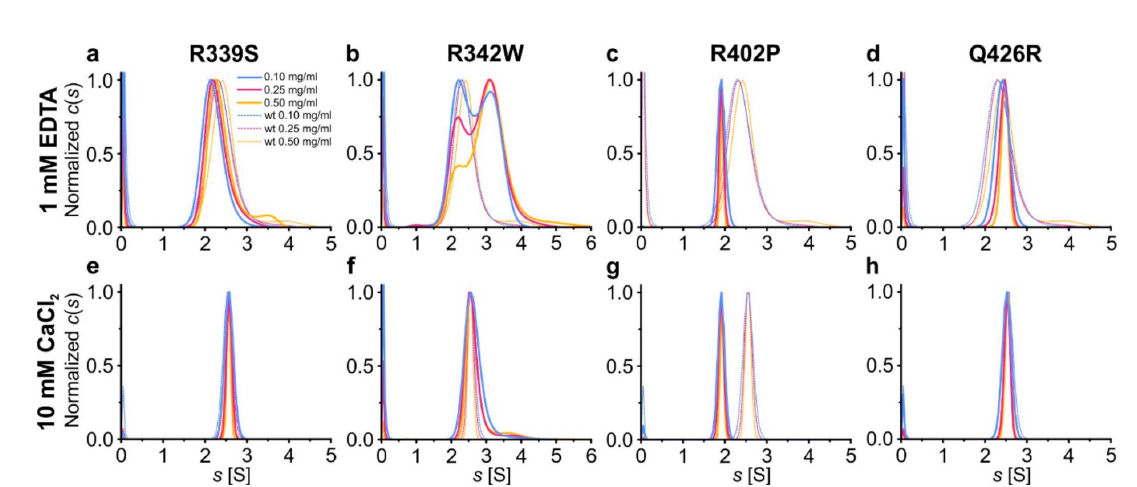
Figure 2. Influence of the mutations on oligomerization of hOtolC1q. Variants of hOtolC1q: ( a , e ) R339S, ( b , f ) R342W, ( c , g ) R402P, ( d , h ) Q426R were subjected to sedimentation velocity analytical ultracentrifugation at concentrations of 0.1–0.5 mg/mL in the presence of ( a – d ) 1 mM EDTA or ( e – h ) 10 mM Ca 2+ . The c ( s ) distributions are shown as solid lines. The dashed lines in the background show the c ( s ) distributions calculated for wild type